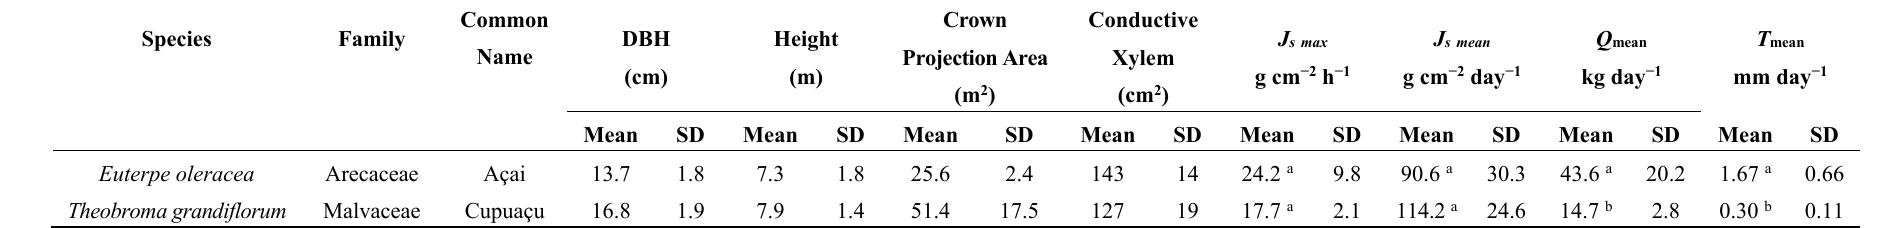
Table 1. A summary of the plant structural characteristics of the studied trees and palmsand a summary of the maximum ( J s max ), mean ( J s mean ) daily sap flux density, mean daily water use ( Q mean ) and mean ( T mean ) transpiration rates (means and standard deviations (SD), n = 3). Significant differences between the two species ( p < 0.05) are indicated by different superscripted